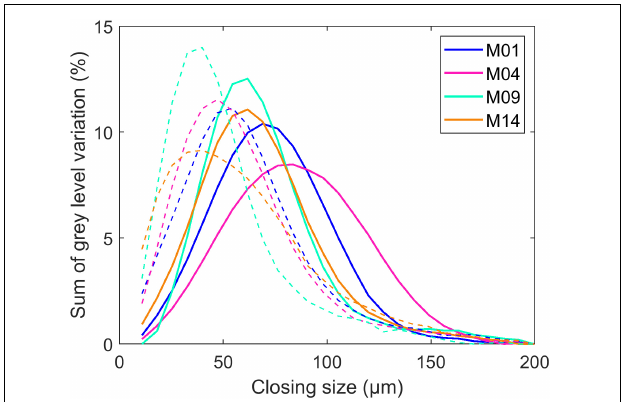
FIGURE 6 | Parenchyma cell size. Example of granulometric curves computed for four inbred lines. The solid and dashed lines represent the granulometric curves computed in the middle parenchyma and the parenchyma near the rind, respectively. Granulometric curves can be compared to normal particle size distributions, with the position of the mode indicating the predominant cell size and the width reflecting the heterogeneity of cell sizes. Because the cells are isotropic, the closing size can be interpreted as the cell